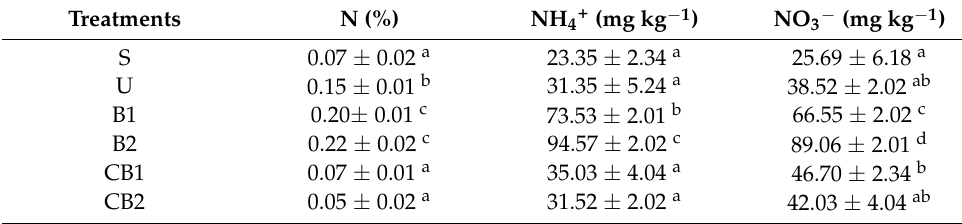
Table 5. Effects of rice straw biochar on soil N, NH 4+ , and NO 3 − of pot experiment.